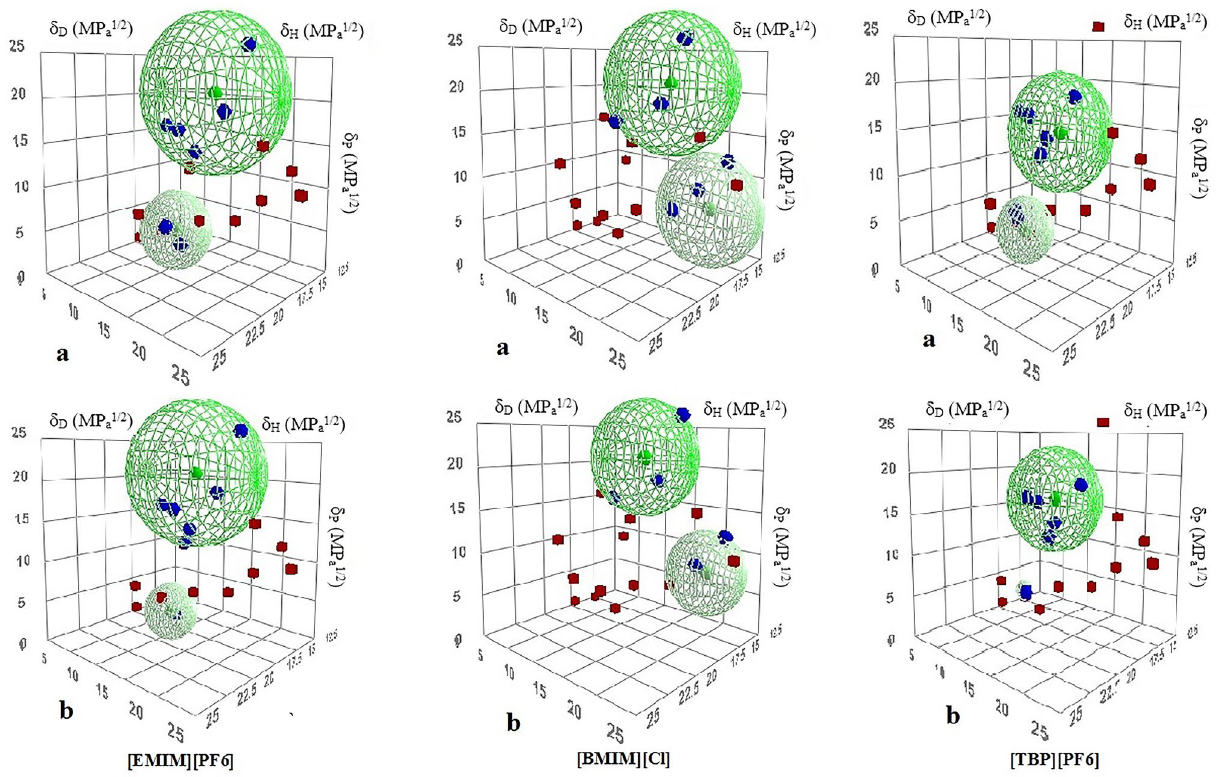
Fig. 1 Double Hansen’s spheres determined for [EMIM][PF6], [BMIM][Cl] and [TBP][PF6]; a calculated with HSPiP., b calculated with Evolu- tionary algorithm of solver add-in from Microsoft